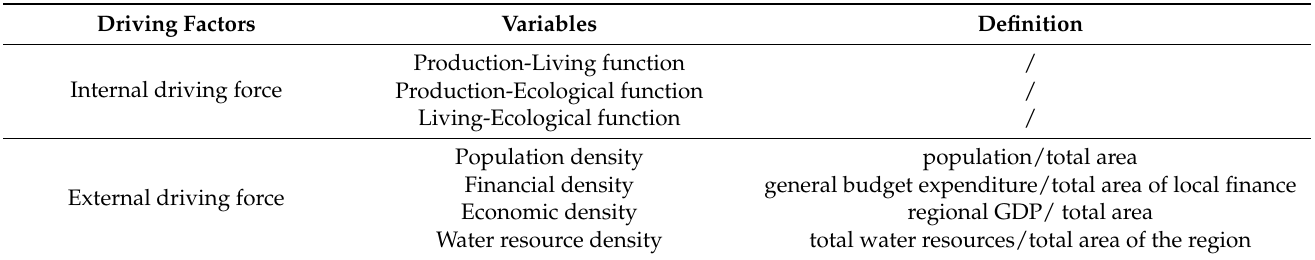
Table 3. Selection of driving factors for “production-living-ecology” functional coordination. Driving